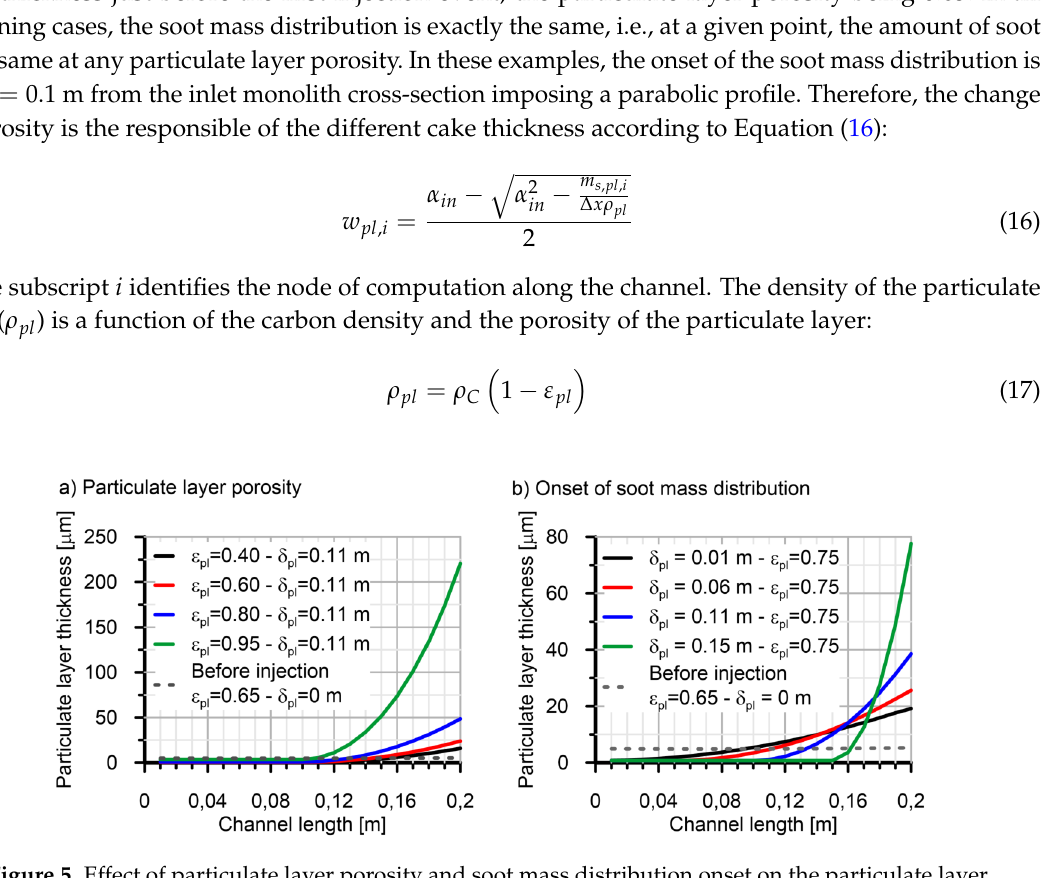
Figure 5. Effect of particulate layer porosity and soot mass distribution onset on the particulate layer thickness profile in DPF